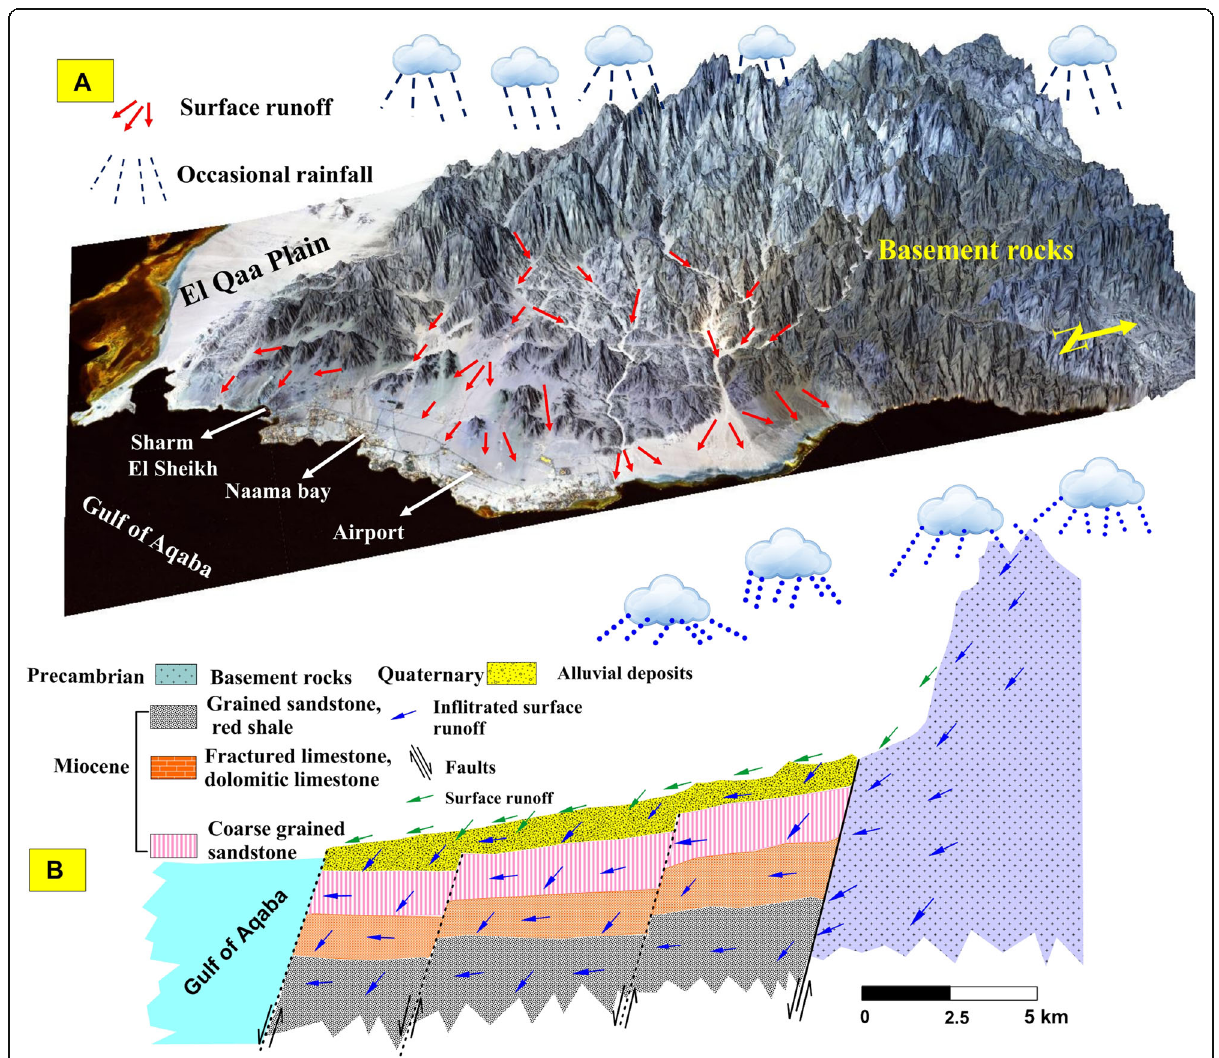
Fig. 13 Conceptual models clarify the surface-groundwater interaction and the recharge mechanism. a Three dimensional view showing the main directions of surface runoff resulting from any flash floods and affecting Sharm El Sheikh City and its vicinities. b Conceptual model shows the possibility of surface runoff infiltration to the subsurface